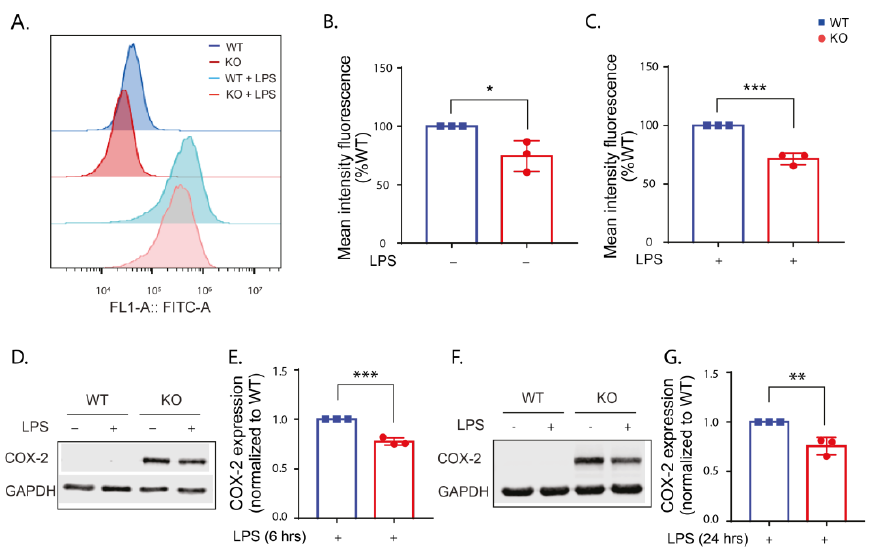
Figure 6. COX-2 is reduced in the KO cells with and without LPS stimulation compared to the WT. ( A ) Histogram showing representative FACS sample analysis of WT and KO cells with/without LPS stimulation for 24 h. ( B , C ) Analysis of the mean FITC fluorescence (representing COX-2 expression) in the WT and KO cells normalized to the corresponding WT. ( D , F ) Representative Western blots for lysates from WT and KO cells with and without LPS stimulation for 6 ( D ) and 24 ( F ) hours and immunoblotted with COX-2 antibody and GAPDH antibody as a loading control. ( E ) Fold change in COX-2 expression in the KO cells normalized to the WT calculated for 6 h LPS stimulation and ( G ) 24 h LPS stimulation. The experiments were performed 3 times and t -test was used to compare COX-2 expression in the KO cells normalized to the WT. Error bar represents mean ± SD. p -values indicating statistically significant differences between the mean values are defined as follows: ns — not significant, * p < 0.05, ** p < 0.01, *** p < 0.001.